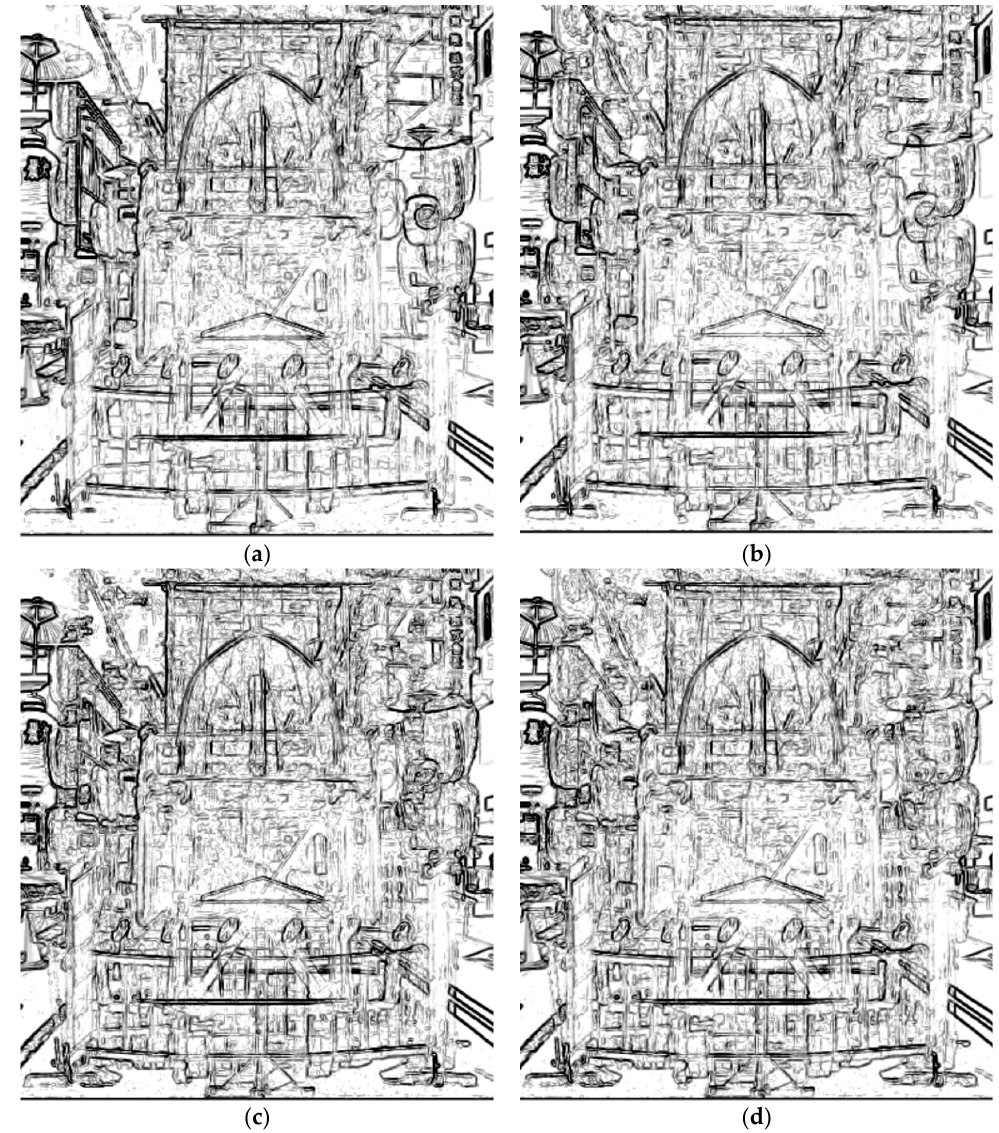
Figure 8. Results of edge extraction by applying a Sobel filter to the fused transparent visualization images: ( a ) original fused transparent visualization, ( b ) lightness adjustment only, ( c ) color enhancement only, and ( d ) improved fused transparent visualization by the proposed method.